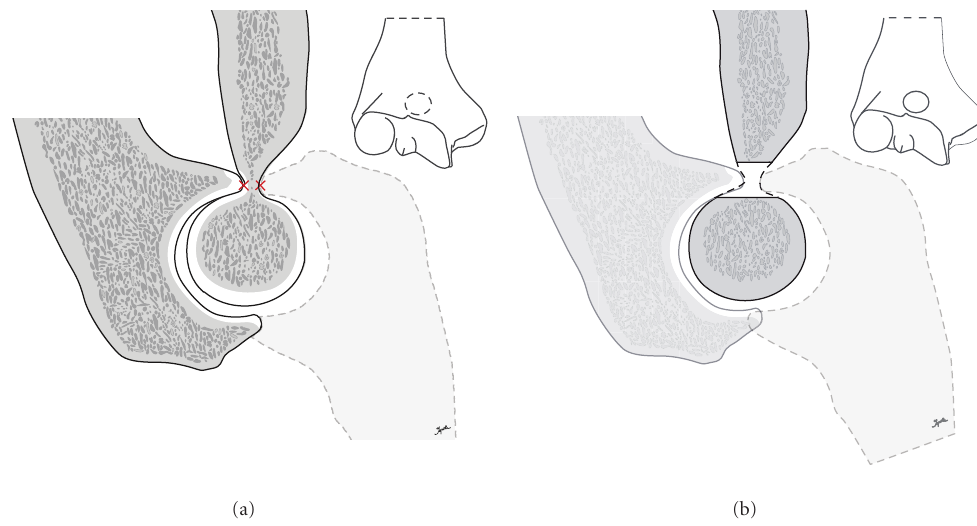
Figure 1: Schematic drawing of the impingement of the coronoid process and the olecranon tip in the anterior and posterior humeral fossae in case of early cubarthritis with the formation of osteophytes which impinge in maximal flexion and extension of the joint (a). This is resolved by a decompressing e ff ect after trepanation of the distal humerus (b).